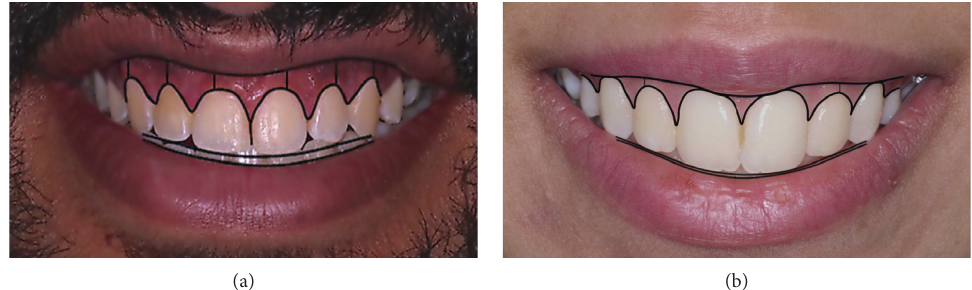
Figure 2: (a) Male subject showing parallel smile and high lip line. (b) Female subject showing parallel smile and medium lip line.